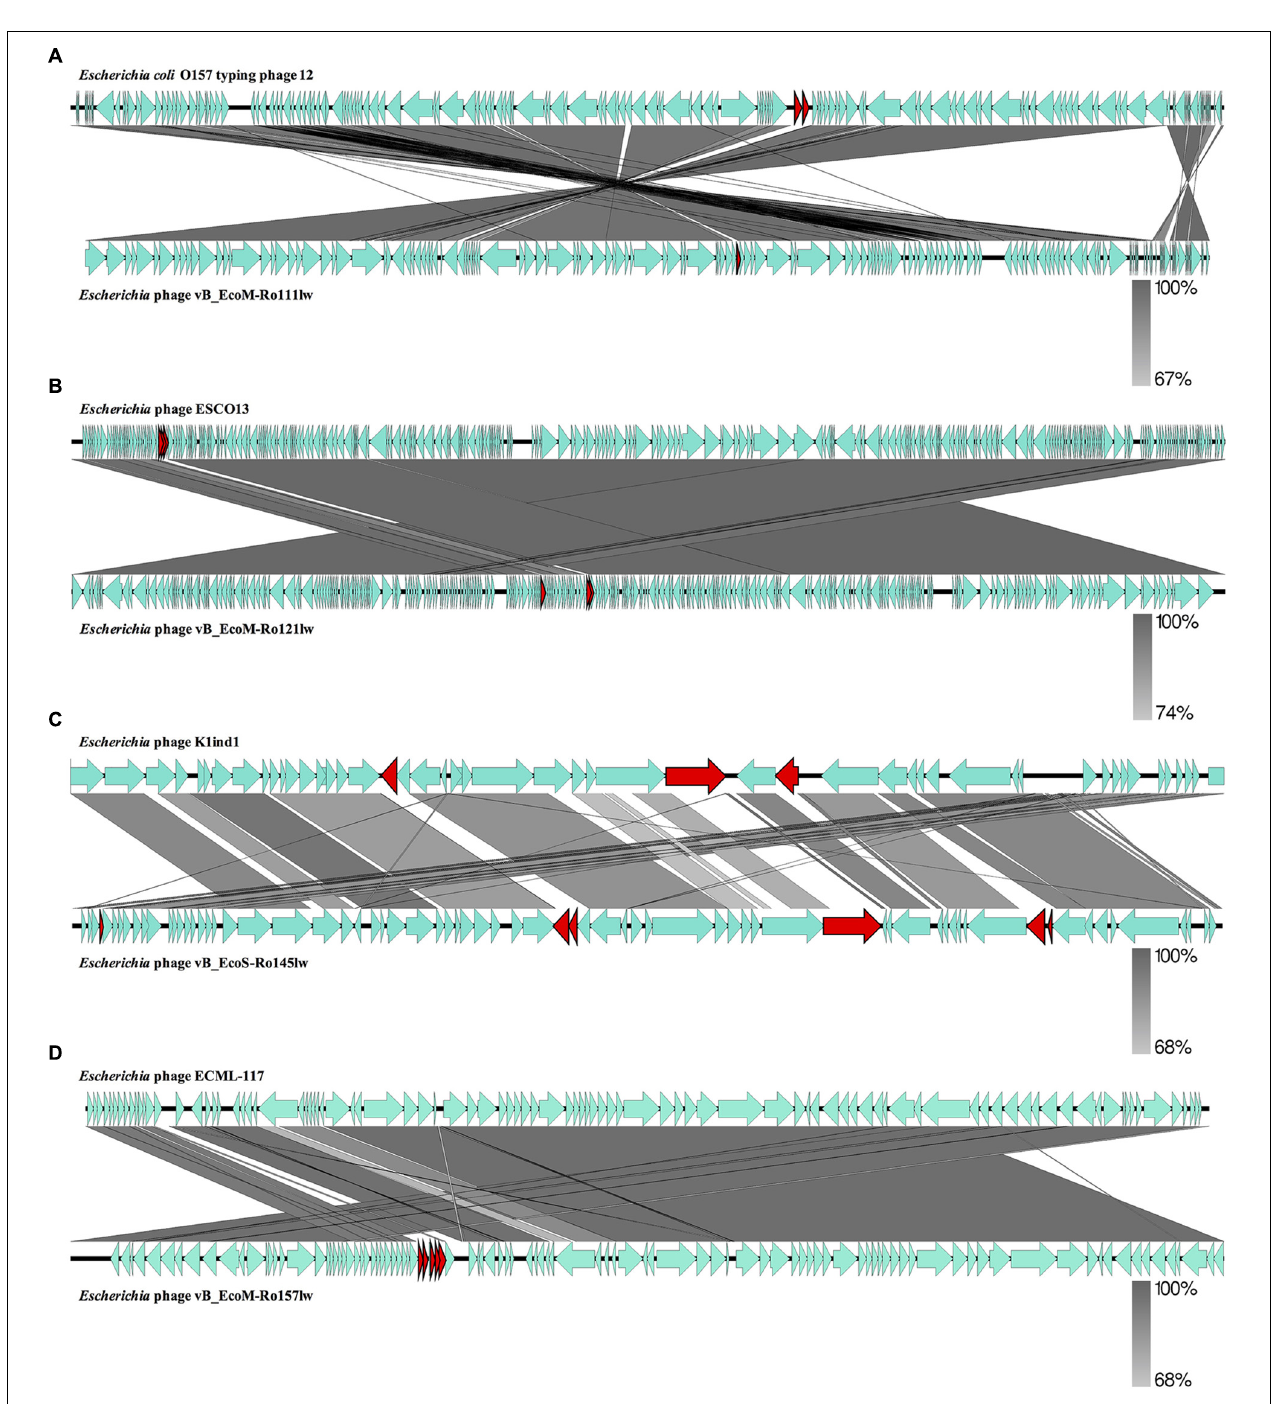
FIGURE 2 | Whole genome comparison of Escherichia phage vB_EcoM-Ro111lw (A) , Escherichia phage vB_EcoM-Ro121lw (B) , Escherichia phage vB_EcoS-Ro145lw (C) , and Escherichia phage vB_EcoM-Ro157lw (D) with their reference genomes from NCBI database using EasyFig. A gray-scaled shaded area indicates the different levels of sequence similarity between two phage sequences. The arrow shapes indicate the annotated ORFs in the genome, and the unshared ORFs are highlighted as red arrows.